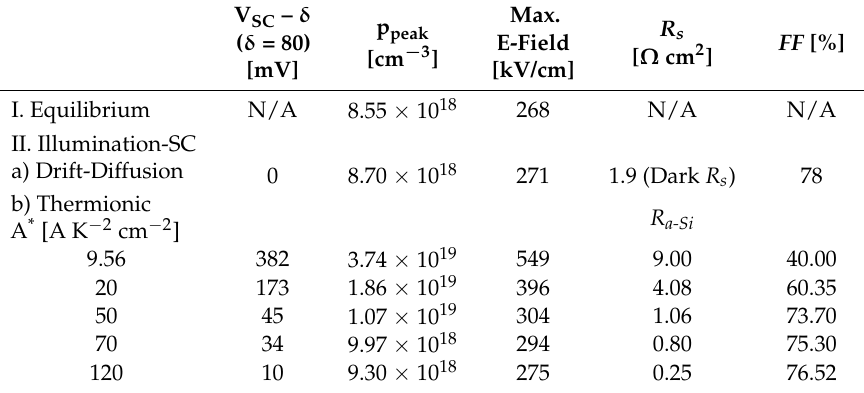
Table 3. Dependence of enhanced a-Si:H series resistance in SHJ 1 on hole thermionic emission probability (A *